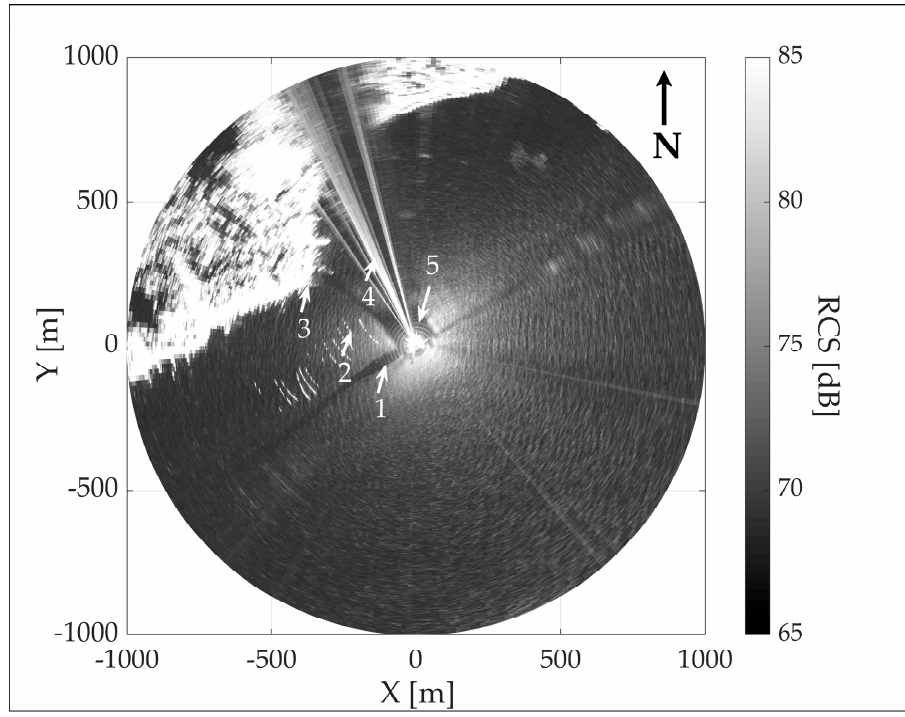
Figure 3. MRS-1000 radar snapshot with an artificial slick band: slick band (1); the anchored oyster farm buoys (2); the coastline (3); the area of the re-reflection (4) the dead zone of the radar (5).